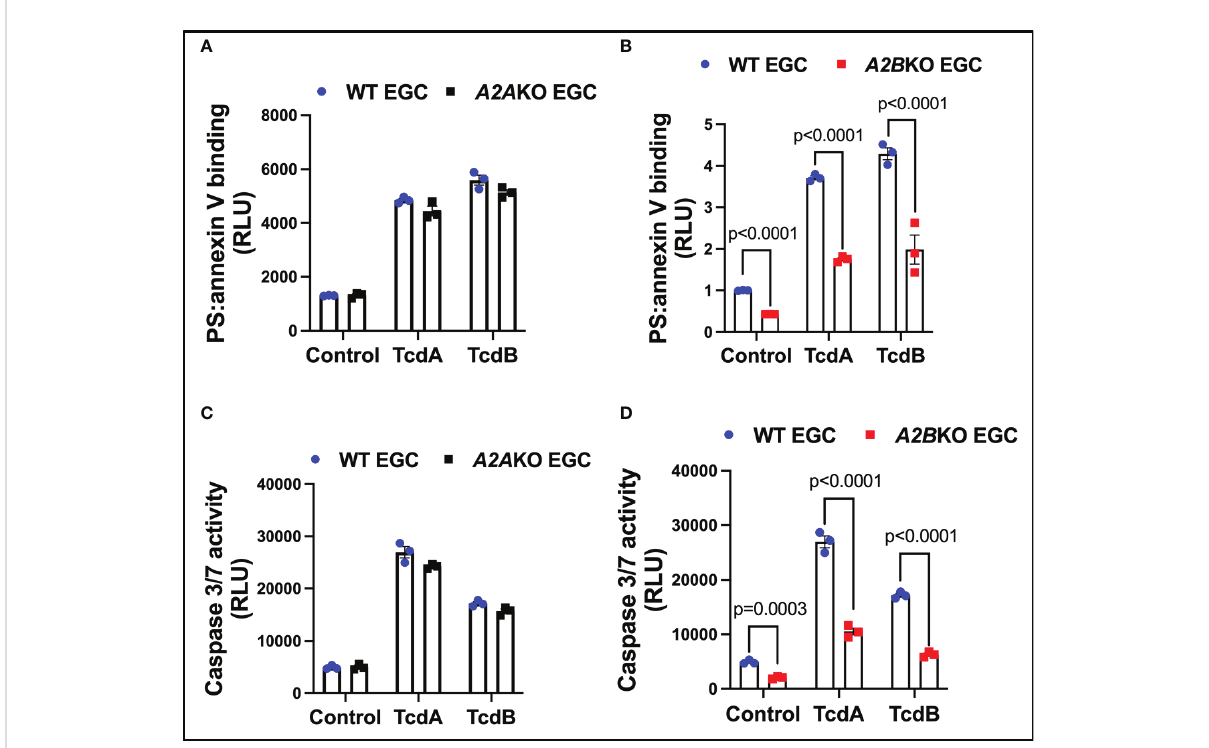
FIGURE 3 Knockdown of A2B , but not A2A , attenuates EGCs death induced by C. dif fi cile toxins. (A, B) Cell death analyzed by RealTime-Glo annexin V apoptosis assay (mean ± s.e.m, n=6) in WT, A2AKO and A2BKO enteroglial cell (EGC/PK060399) challenged with TcdA and TcdB for 18 h. (C, D) Activity of caspase 3/7 analyzed by luminescence assay (mean ± s.e.m, n=6) in WT, A2AKO and A2BKO enteroglial cell (EGC/PK060399) challenged with TcdA and TcdB for 18 h. (A – D) One-way ANOVA followed by Turkey test was used. These experiments are from two different